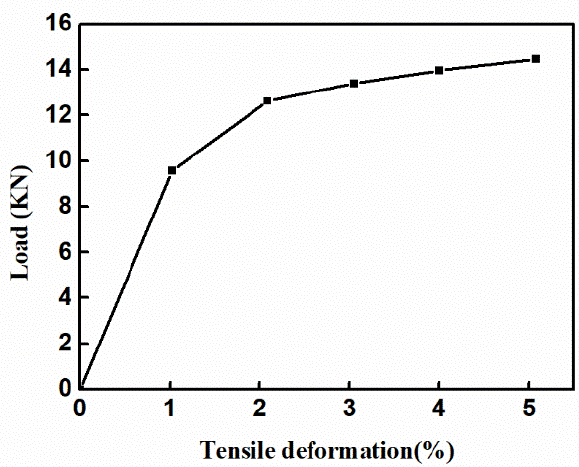
Figure 9. Loading force at different tensile deformation. (The picture has been replaced with a higher quality).